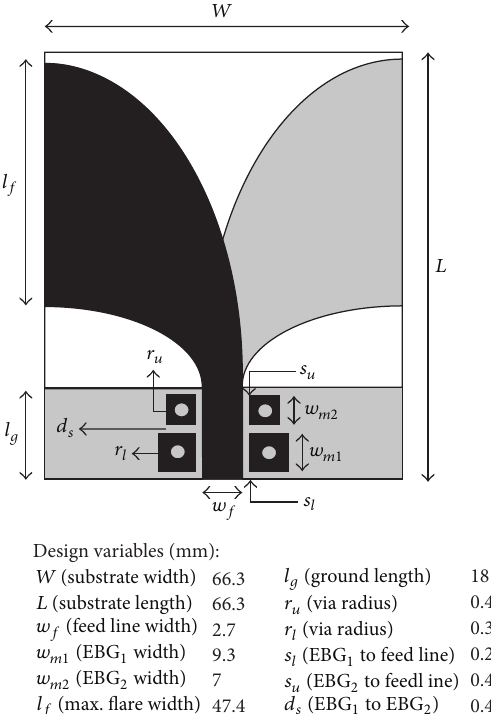
Figure 1: Proposed AVA: black and gray strips refer to upper and lower flares, respectively.